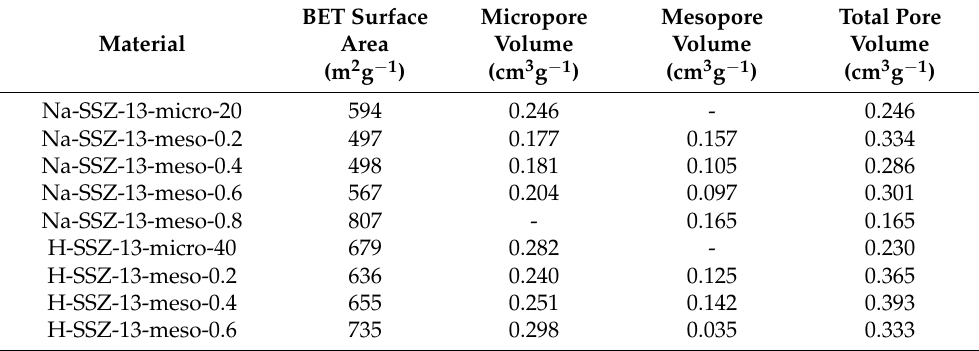
Table 2. Nitrogen physisorption